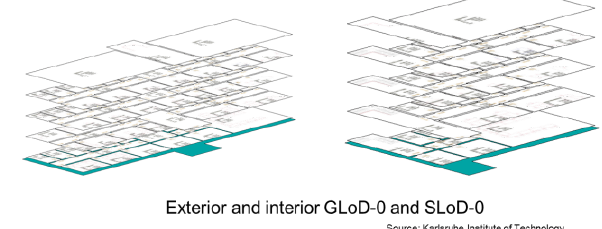
Figure 12: Building exterior and interior as horizontal textured